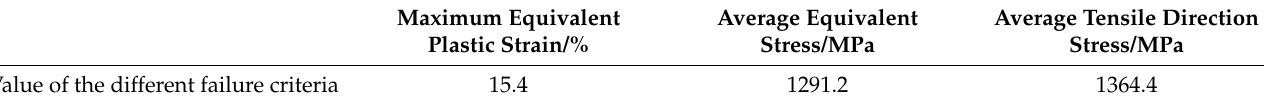
Figure 23. The variation of average tensile direction stress with tensile load. Table 4. The failure criteria of the specimen.